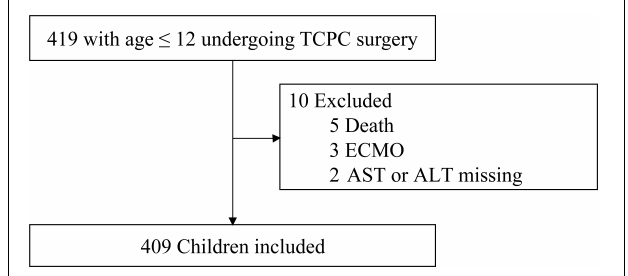
FIGURE 1 | The flowchart of inclusion and exclusion